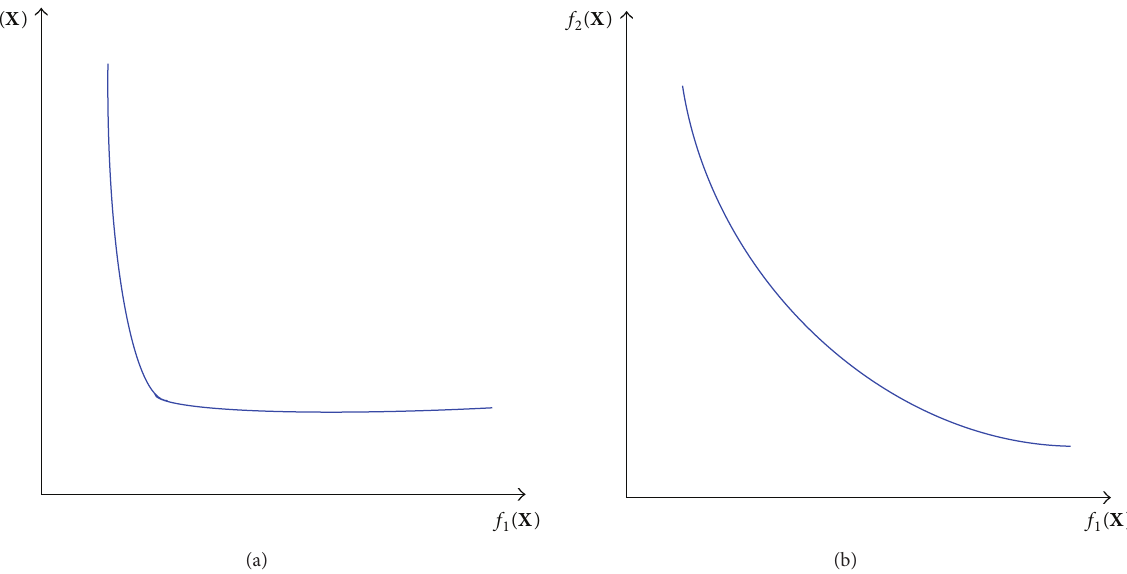
Figure 4: Illustration of (a) a sharp Pareto front and (b) a rather linear Pareto